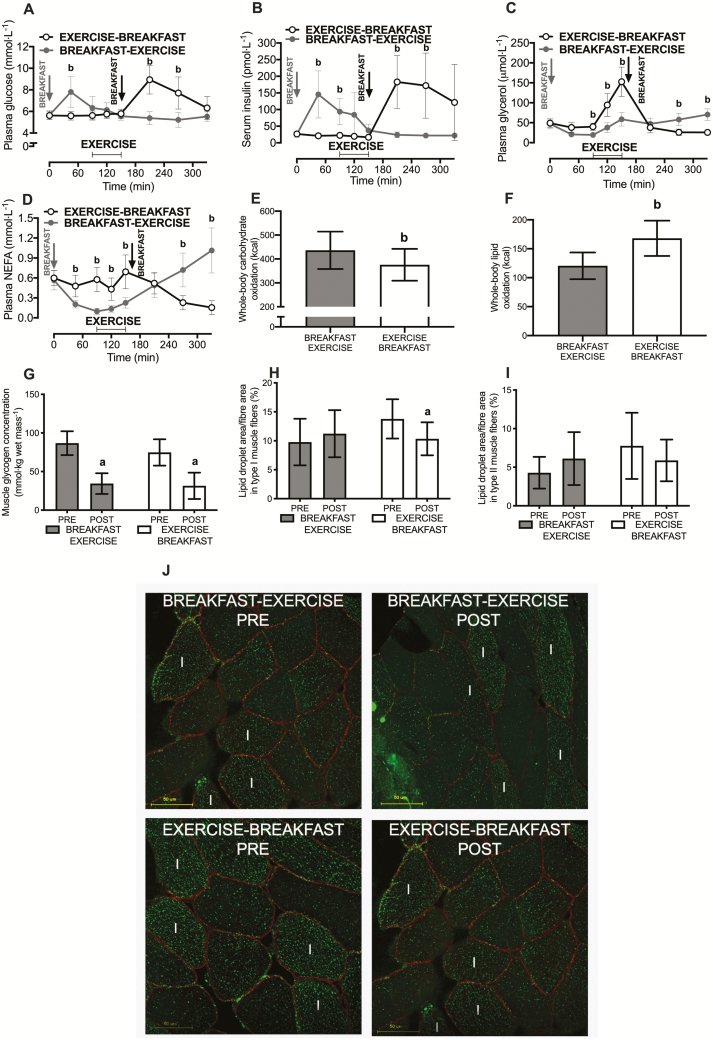
Plasma glucose (A), serum insulin (B), plasma glycerol (C), and plasma NEFA (D) concentrations and whole-body carbohydrate (E) and lipid (F) utilization rates. Muscle was sampled pre-exercise and immediately postexercise (vastus lateralis) to assess mixed-muscle glycogen (G) and fiber-type specific intramuscular lipid (IMTG) utilization (H & I). Panel J shows representative images from IMTG staining where IMTG (stained green) in combination with dystrophin (to identify the cell border and stained red) is shown from skeletal muscle samples of a representative participant for the carbohydrate-exercise and exercise-carbohydrate trials. White I shows type 1 fibers, and all other fibers are assumed to be type II. Yellow bars are scale (50 μm). All data are presented as means ± 95% confidence interval. For panels A–F, n = 12 men classified as overweight or obese; for panels G, H, and I, n = 9. The difference between PRE versus POST exercise is designated by a; and the difference between BREAKFAST-EXERCISE versus EXERCISE-BREAKFAST is designated by b. (P < 0.05).